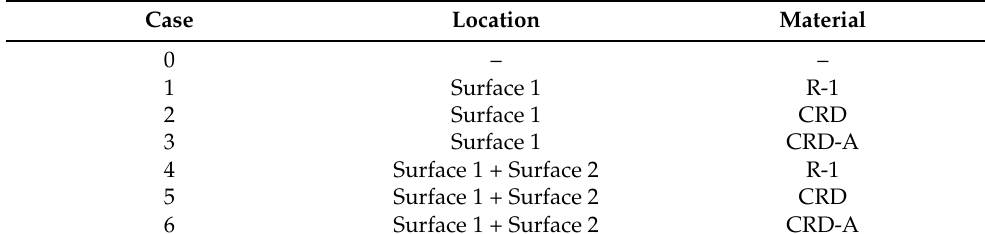
Table 1. Room conditions for impulse response measurements.